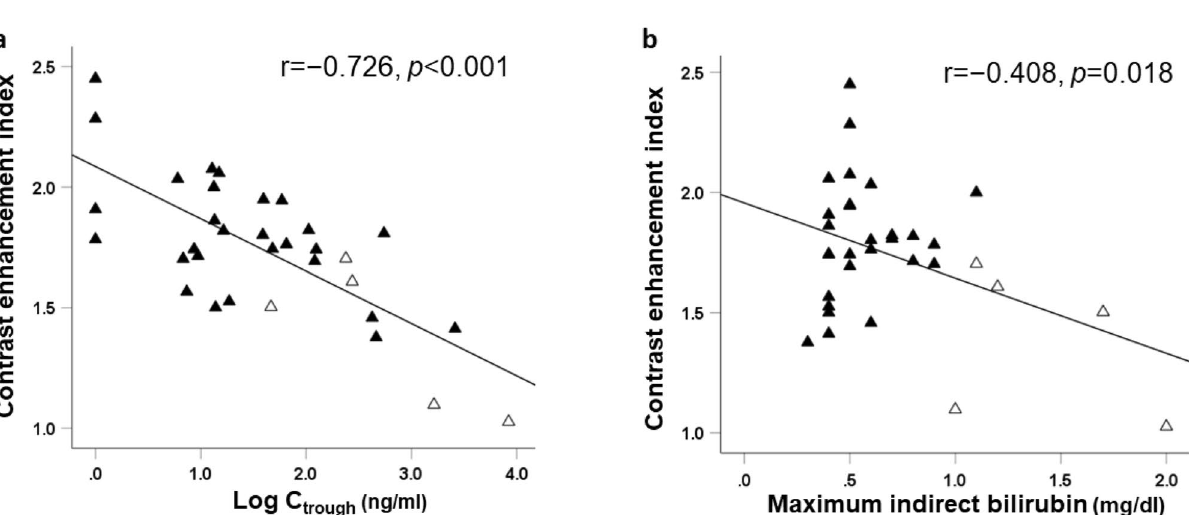
Figure 2. Relationship between contrast enhancement index and ( a ) glecaprevir trough concentration, or ( b ) maximum indirect bilirubin. Black triangle, patients without grade ≥ 2 hyperbilirubinemia; open triangle, patients with grade ≥ 2 hyperbilirubinemia. CEI contrast enhancement index, C trough trough concentration of glecaprevir. Data were analyzed using Pearson’s